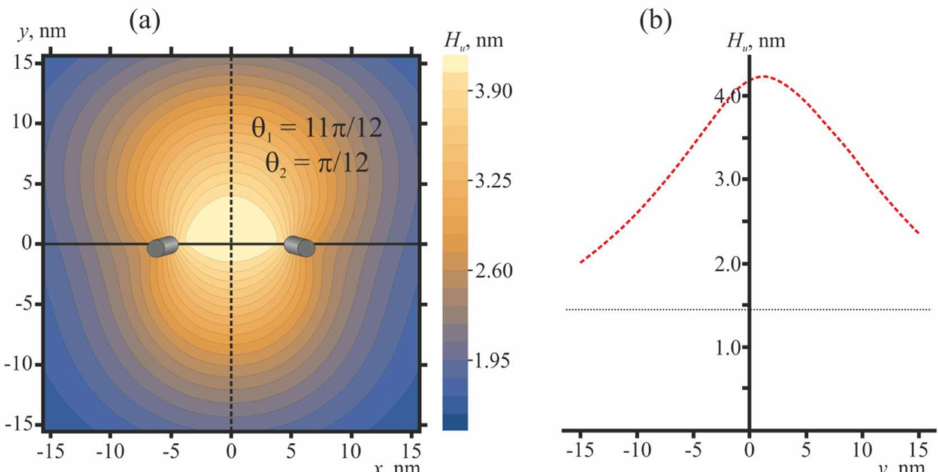
Figure 7. Membrane shape in the vicinity of two pulled peptide trimers ( ∆ H = 2 nm) in the optimal configuration ( θ 1 = 11 π / 12, θ 2 = π / 12) that corresponds to the conditions of Figure 6c. ( a ) Contour plot of the shape of the neutral surface of the upper monolayer, H u ( x , y ). Peptides are shown as oblique gray cylinders, the centers of which have coordinates x = 5 nm, y = 0, and x = − 5 nm, y = 0. ( b ) Shape of the neutral surface of the upper monolayer, H u (0, y ), along the line x = 0 (dashed black line in panel ( a )) passing in the middle between the peptides. The horizontal dotted line corresponds to the H u value far from the